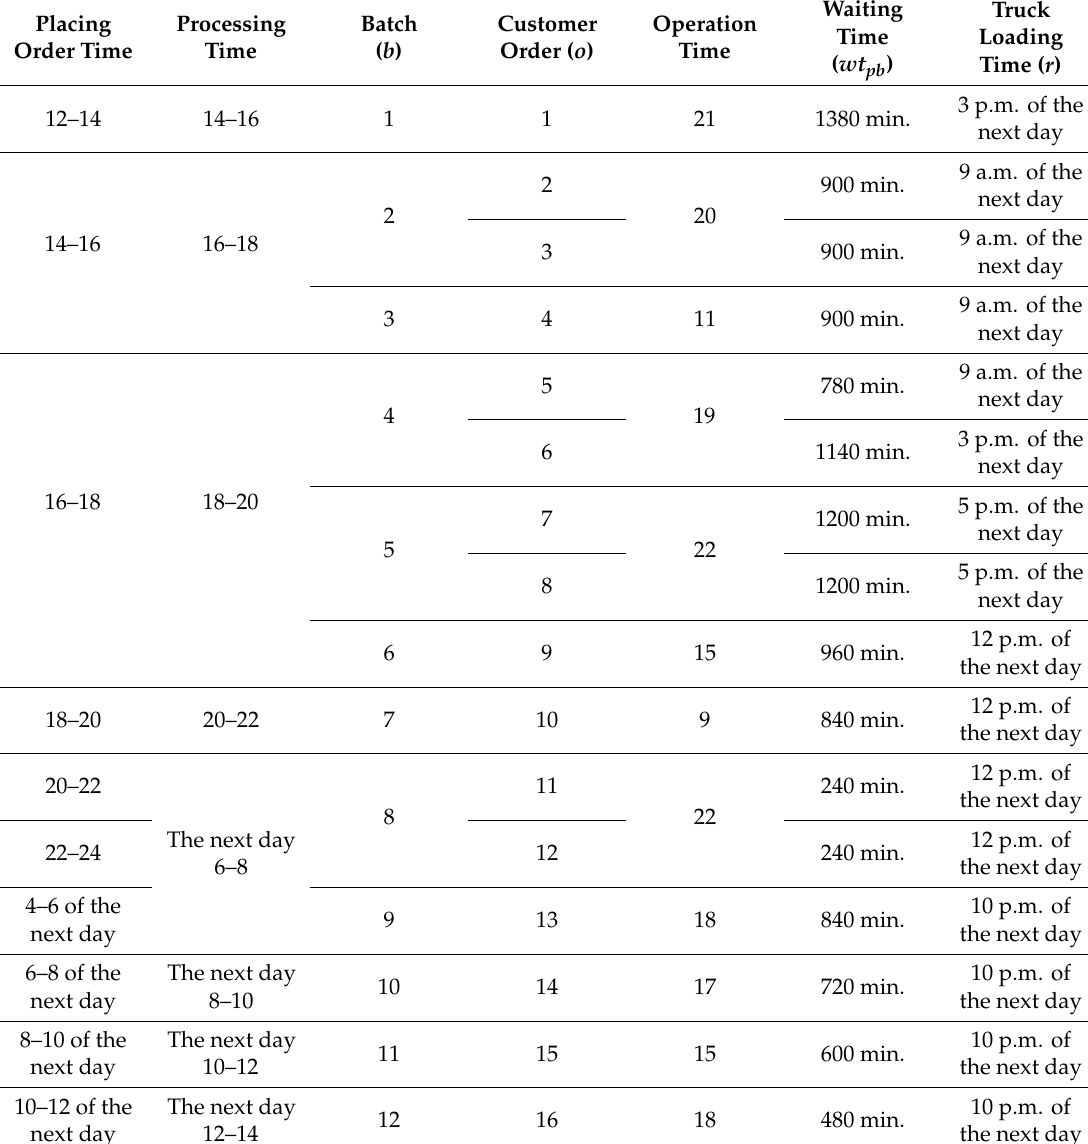
Table 8. The performance of picking before using the